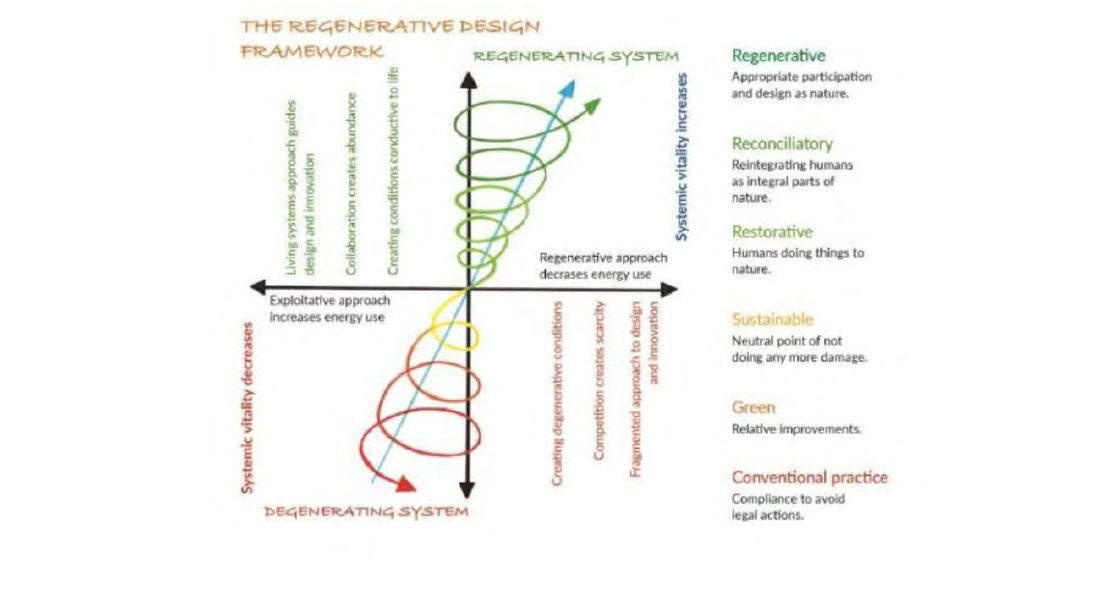
Figure 2. The framework of regenerative design (”The Ecologist”,